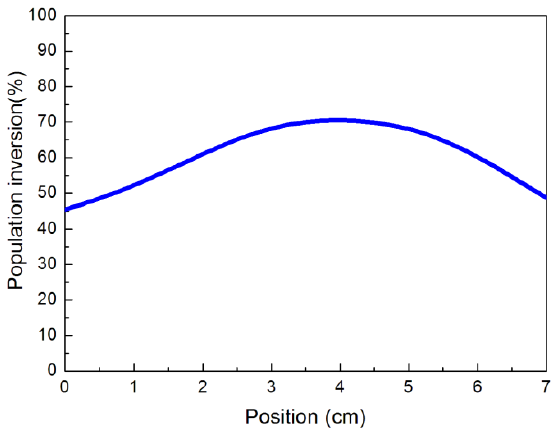
Figure 8. The population inversion along the 7-cm Tm 3+ -doped silicate fiber.